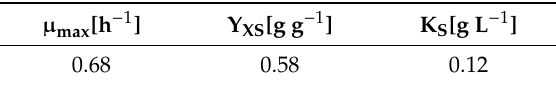
Table A4. Model parameters for the maximum specific growth rate biomass µ max , yield coe ffi cient biomass / substrate Y XS , and monod constant substrate K S . Parameters were estimated by adaptation to batch experiments.